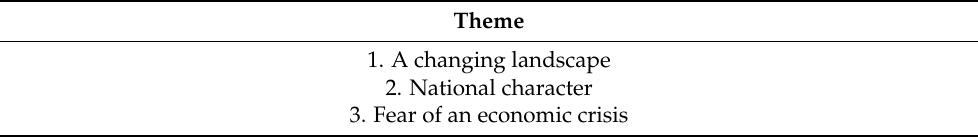
Table 3. Latent Societal Themes in Financial Education Projects in